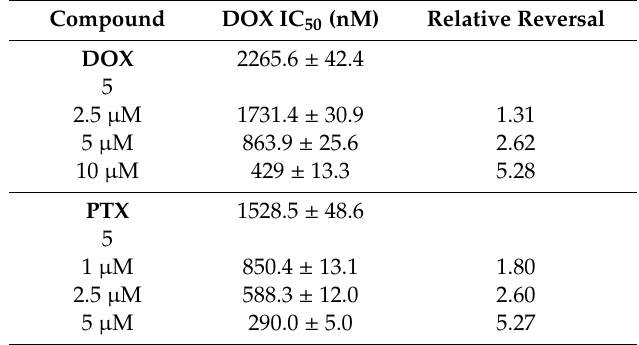
Table 3. Relative reversal of doxorubicin (DOX) and paclitaxel (PTX) resistance in NCI-H460 / R and DLD1-TxR cells induced by Hsp90